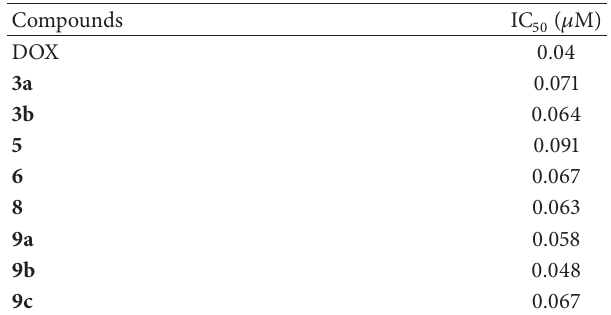
Table 3: IC 50 ( 𝜇 M) of some selected new compounds against liver cancer cell line